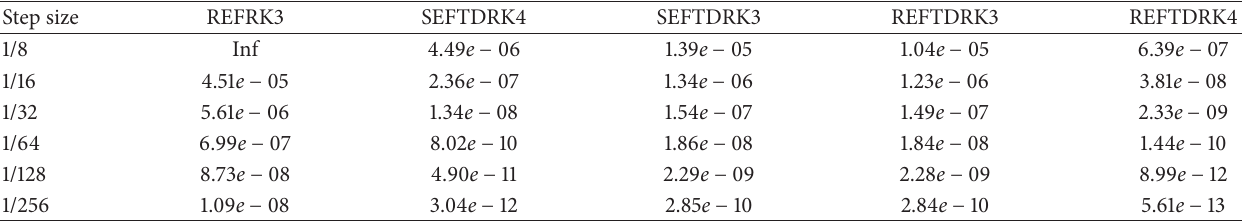
Table 3: The global errors in the final step points obtained by several methods for Problem